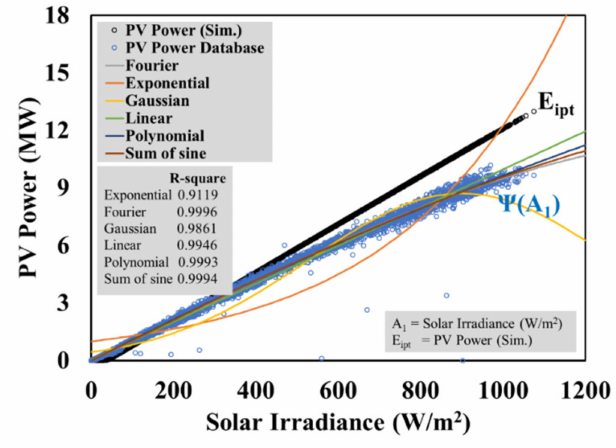
Figure 11. Accuracy improvement of the proposed